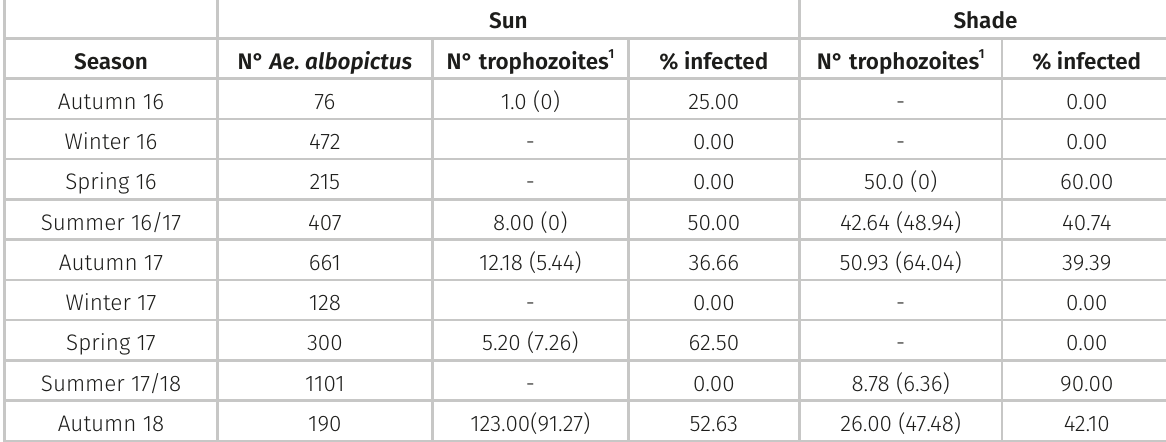
Table II. Seasonal infection rates and number of trophozoites of Ascogregarina sp. in natural populations of Aedes albopictus